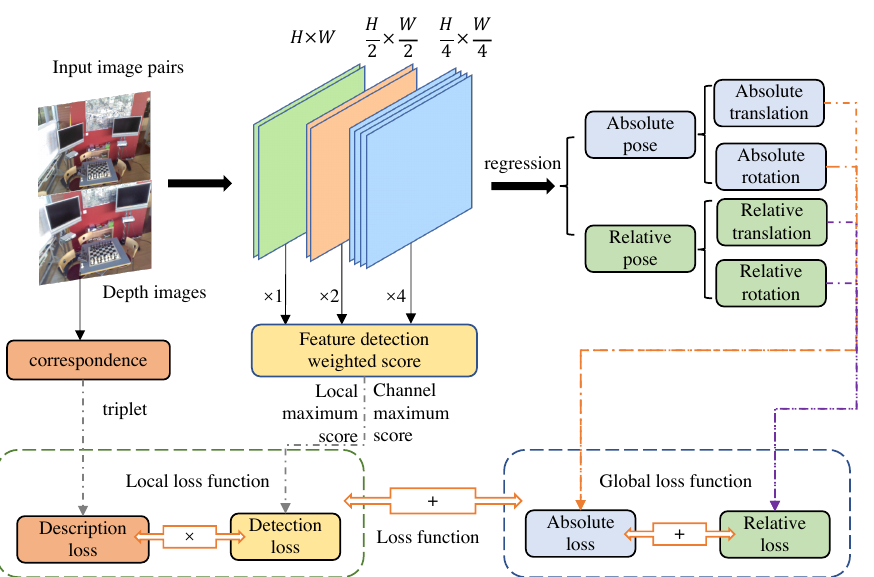
Figure 5. The network architecture fusing local and global features. Figure 4.10.The network architecture fusing local and global features